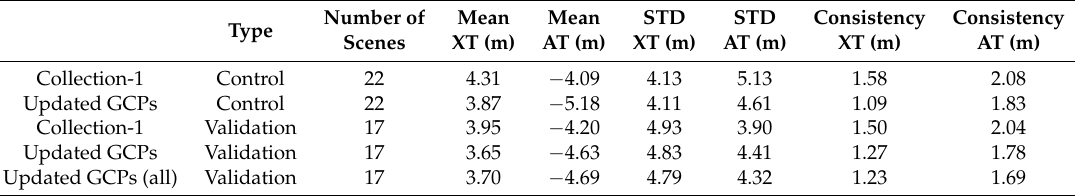
Table 6. Validation of the GCP updates using the geodetic accuracy validation procedure for the Australia block.